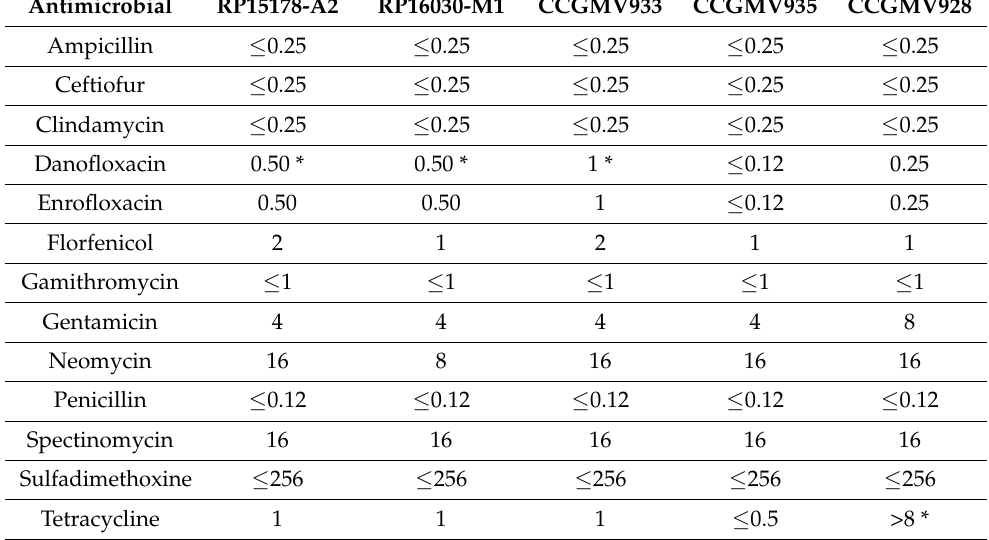
Table 3. Minimal Inhibitory Concentrations ( µ g/mL) obtained using Sensititre Vet Bovine BOPO7F